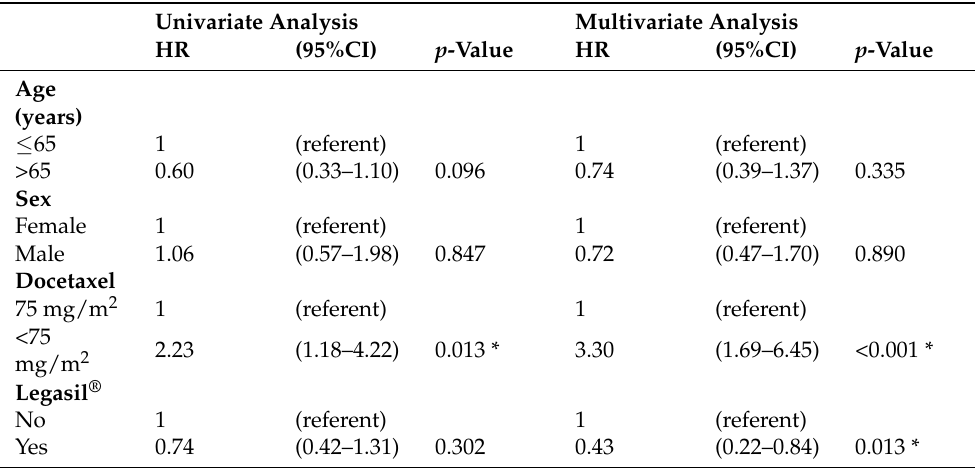
Table 3. Univariate and multivariate Cox proportional analysis for TTF. Univariate Analysis Multivariate